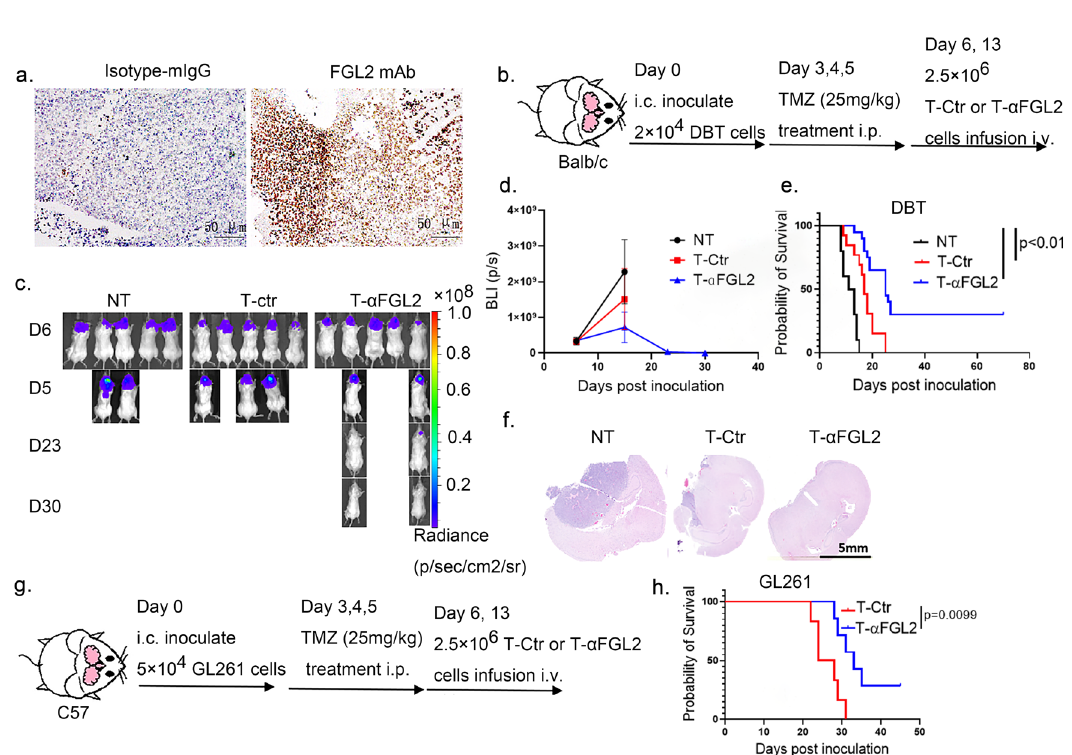
Fig. 2 | Antitumor activity of T- α FGL2 in vivo. a Representative micrographs of FGL2 expression in the brains of mice with glioma. Slides stained with mouse IgG were used as negative controls. Images are representative of results from three samples with multiple fi elds of view for each sample. b Schematic of the orthotopic DBTgliomamodel.Ondays3 – 5afterDBTtumorcellinoculation,miceweretreated with temozolomide (TMZ), followed by infusion of T-Ctr or T- α FGL2 cells on days 6 and 13. c Representative bioluminescence images of DBT-luc tumor growth in the orthotopicgliomamodelshownin( b ). d Fluxvs.time[p/s]data(mean±SEM)forthe orthotopicgliomamodelshownin( b )( n =5mice). e Kaplan –